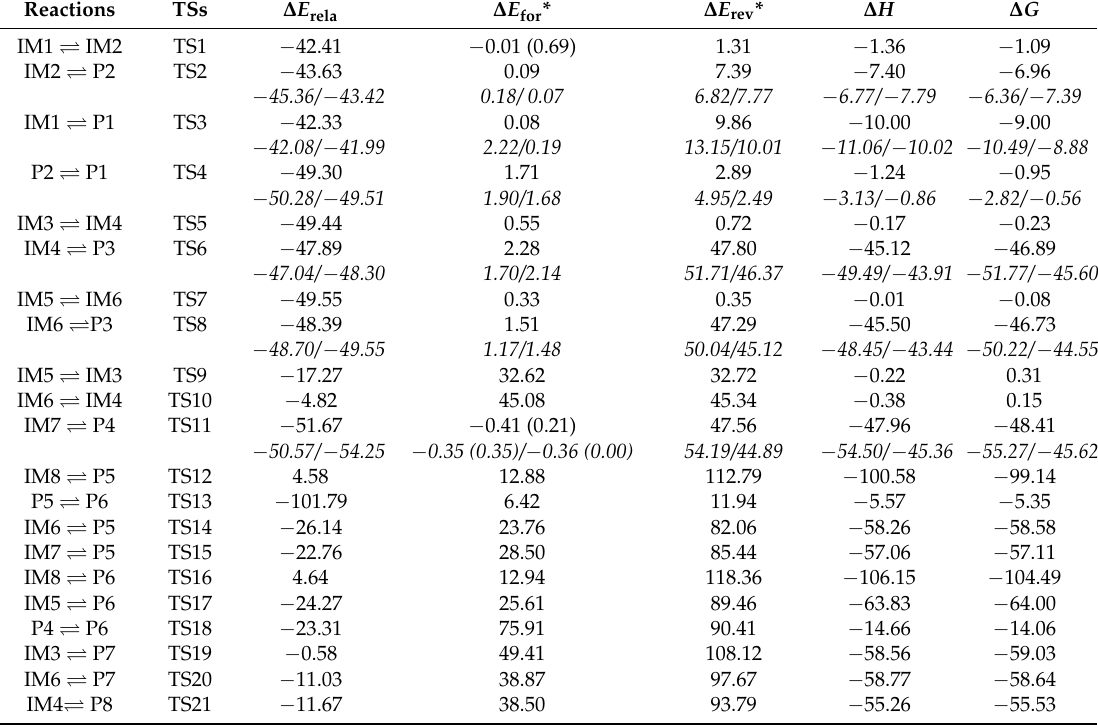
Table 2. Calculated relative energies for the transition state relative to the separated reactants, barrier heights, and the enthalpy and Gibbs free energy changes in the interconversion processes a . Reactions